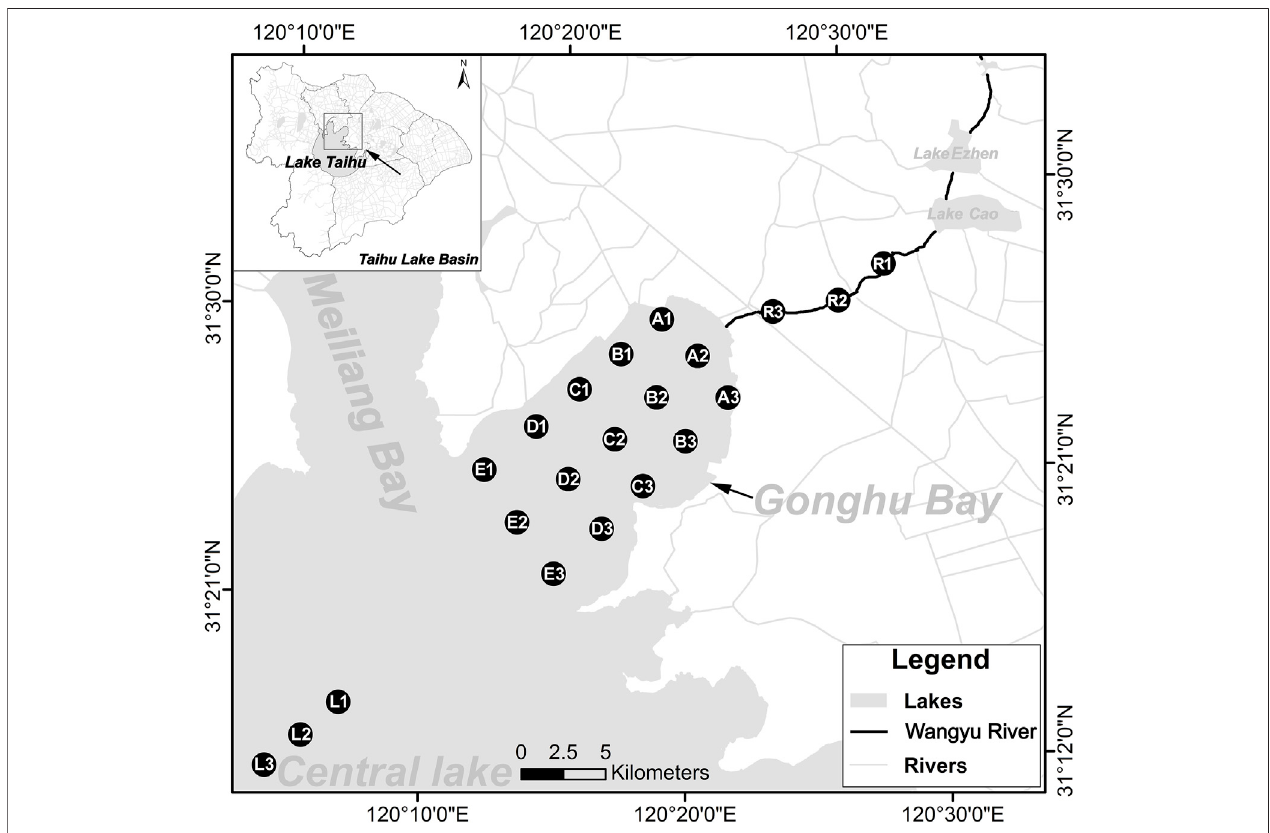
FIGURE 1 | The initial distribution of monitoring sites in Wangyu River, Gonghu Bay, and the lake center of Lake Taihu.